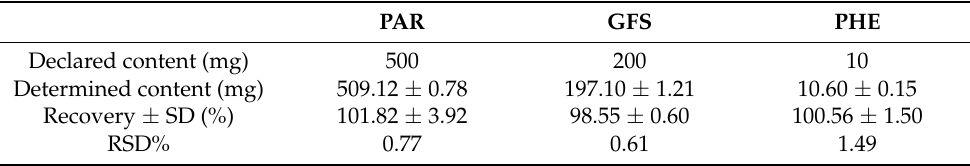
Table 2. Determination of PAR, PHE and GFS in pharmaceutical